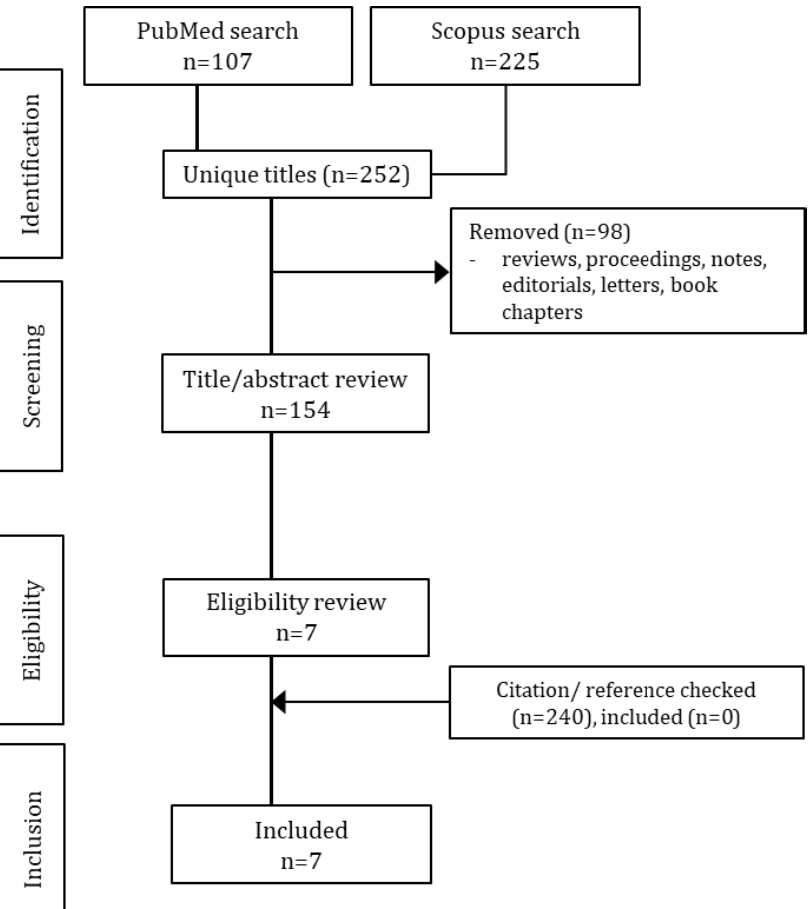
Figure 1. Identification of articles for inclusion. Eligibility was determined using PICOS criteria (Supplementary B). (Supplementary